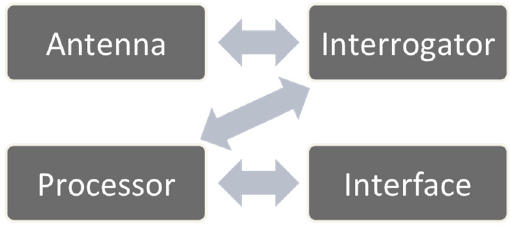
Figure 1. Core components of an RFID reader.